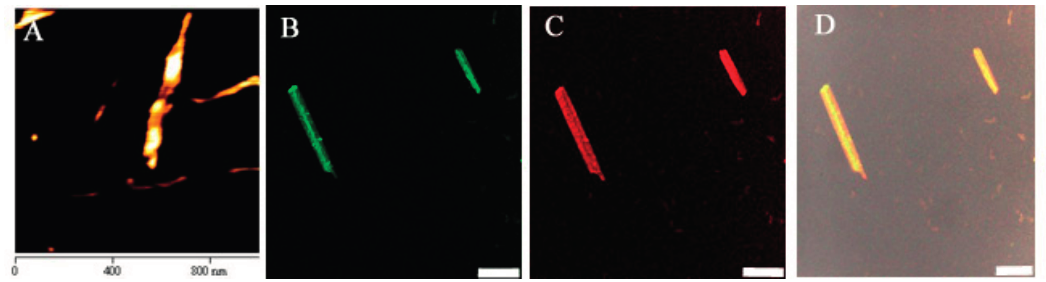
Figure 3. Atomic force microscope ( A ) and fluorescence microscope imaging of TM-rhodamine-labeled CAP3 pRFP-C-RS image (red color) ( C ) formulated with cyclo -( D -Trp-Tyr) ThT pre-stained peptide nanotubes image (green color) ( B ). ( D ) The imaging was merged with ( B ) and ( C ). Scale bars denote 2.5 μ